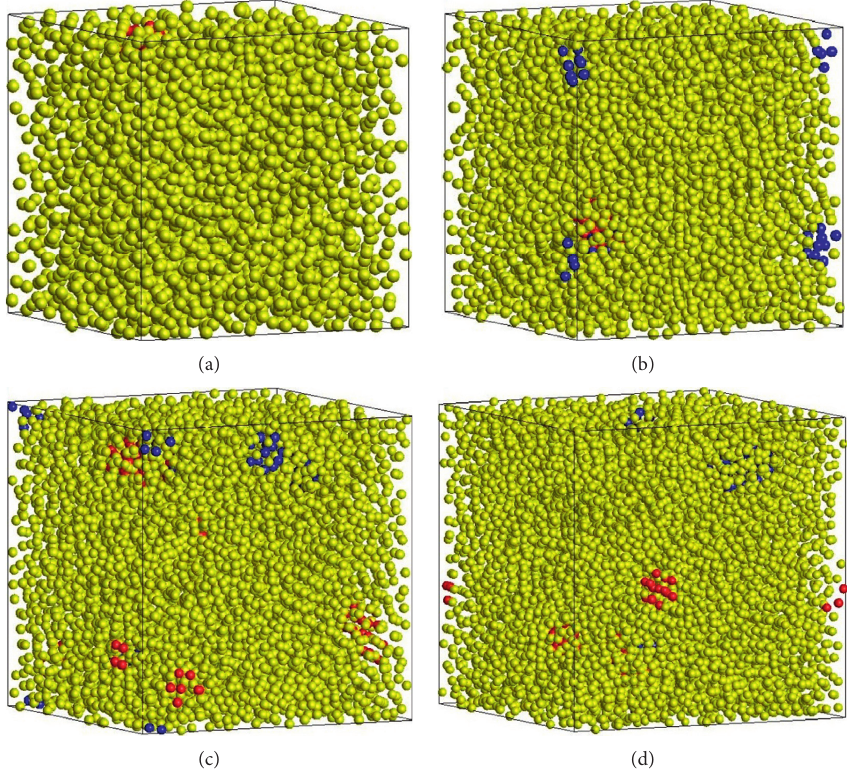
Figure 2: Shape of bulk Al with numbers N � 3000 atoms (a), N � 5000 atoms (b), N � 7000 atoms (c), and N � 9000 atoms (d).